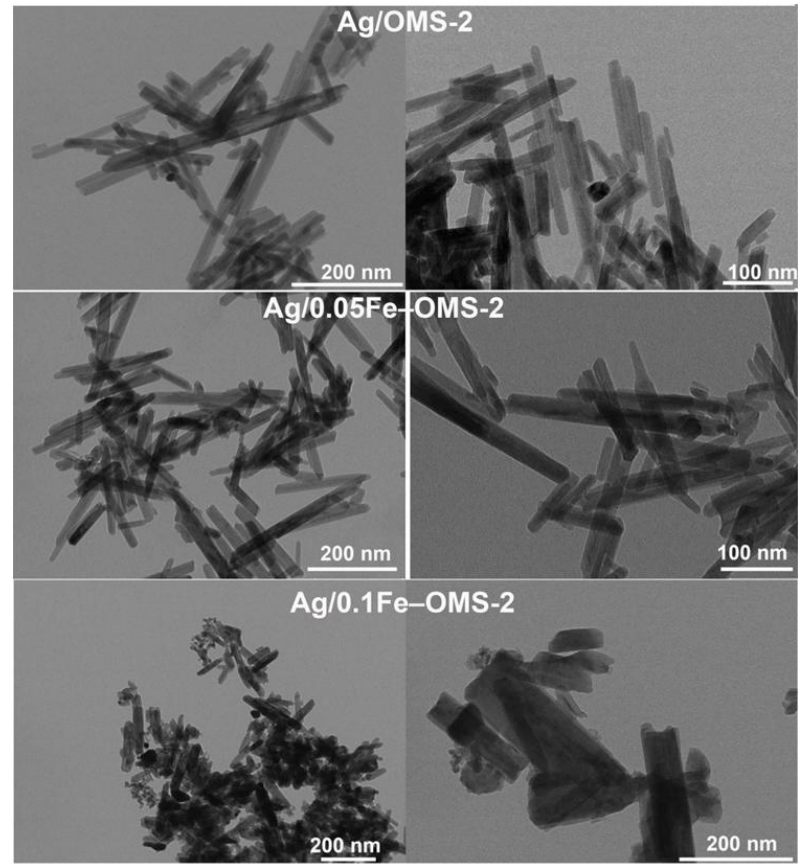
Figure 2. TEM images for investigated samples.